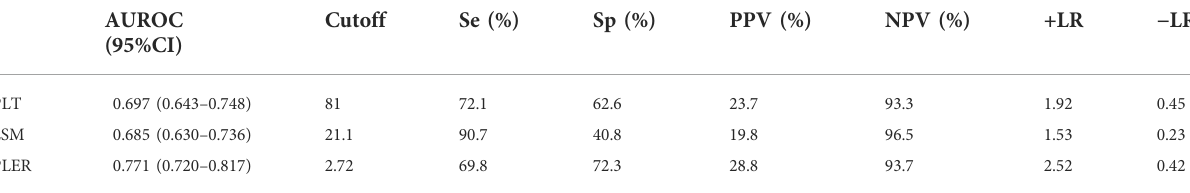
TABLE 2 Performance of PLT, LSM, and PLER for diagnosing HRVs in patients with HBV-related liver cirrhosis beyond Baveno VI criteria. AUROC